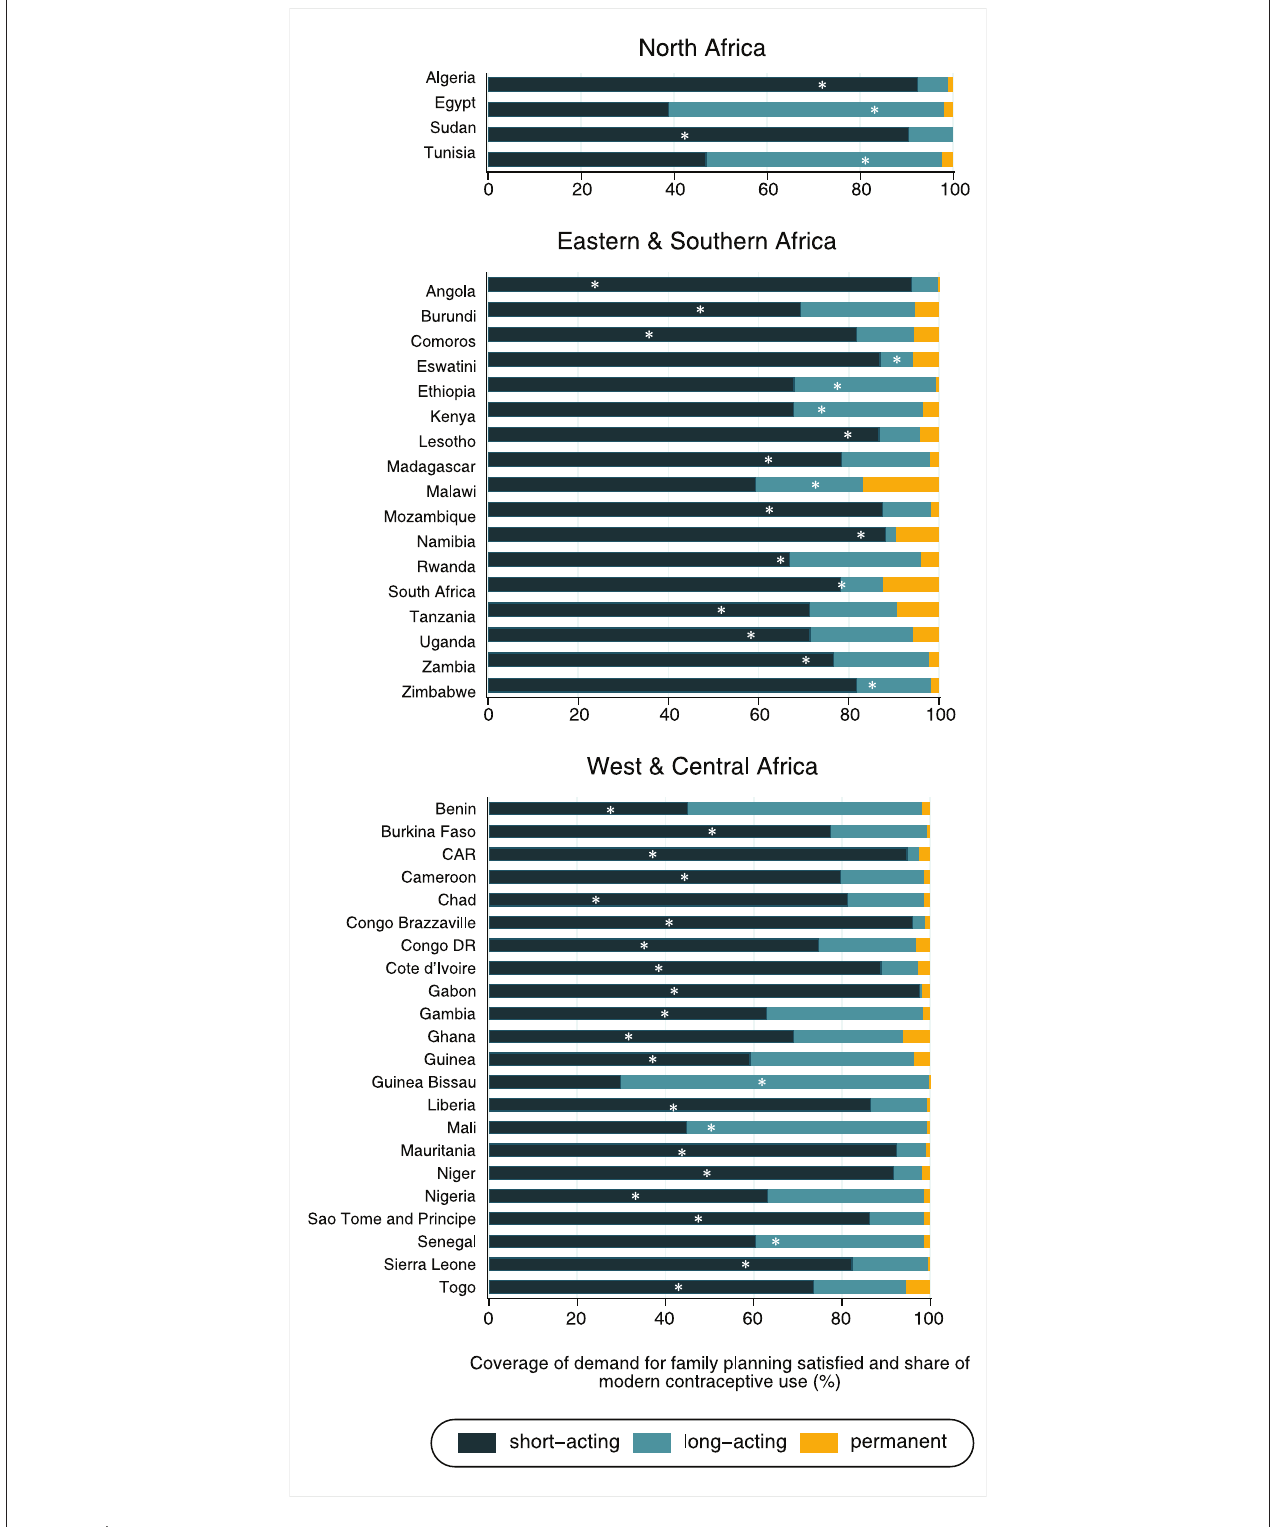
Frontiers in Global Women’s Health |